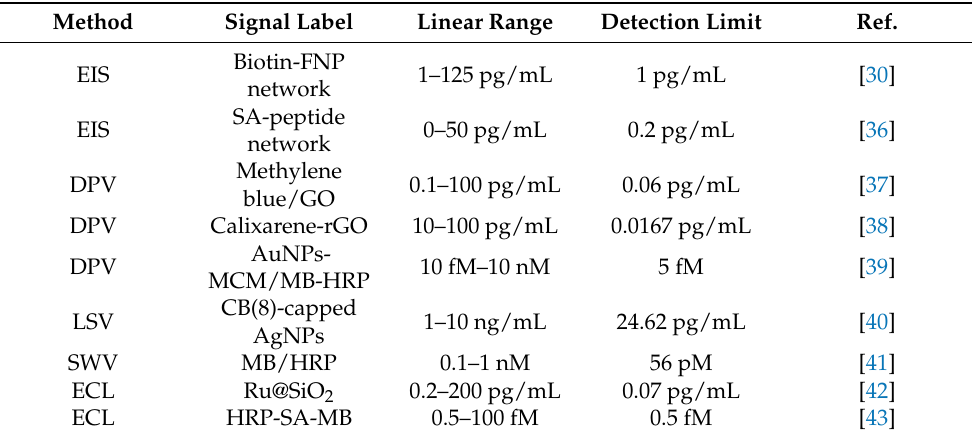
Table 1. An overview of heterogeneous methods for Cas-3 detection based on the signal amplifica- tion of enzymes and nanomaterials.